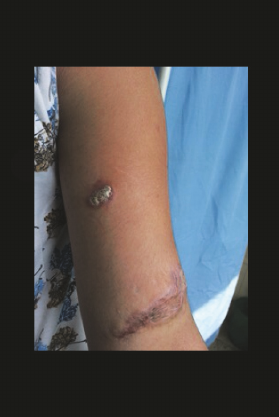
Figure 1: Erythematous plaque ( 2∗1 cm) of lupus vulgaris on right forearm of a 17-year-old female with a history of trauma forming a linear scar ( 4 ∗ 2 cm), visiting